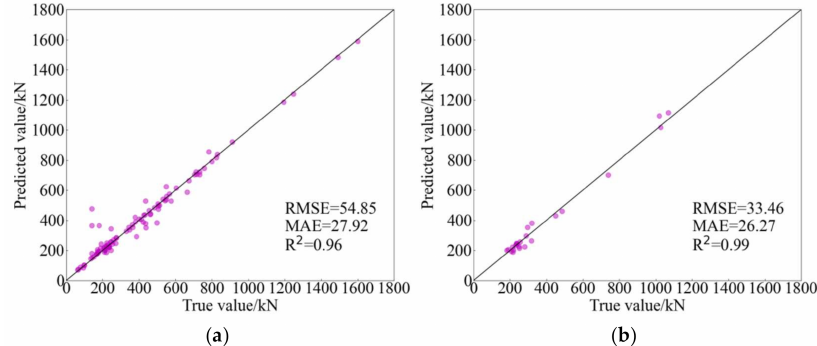
Figure 5. The predictions of PSO-SVR for data set. ( a ) Training set; ( b ) Test